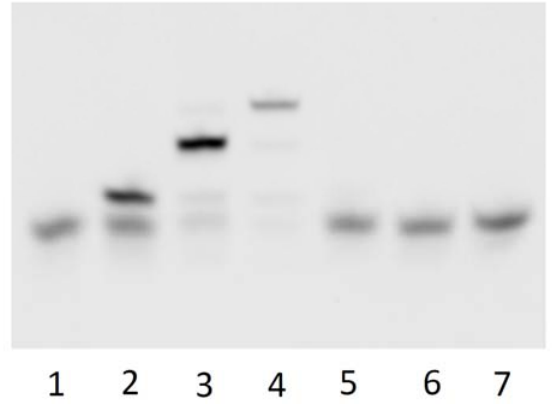
Figure 4. Cy3 fluorescence of a denaturing PAGE of photoreaction of ODN 5, 6, 7 and 8 and template 2 was annealed and photoirradiated at 366 nm for 900 s at 4 °C and 312 nm for 1800 s at room temperature. Lane 1, ODN 5 + template 2 + 366 nm; Lane 2, Lane 1 + ODN 6; Lane 3, Lane 2 + ODN 7; Lane 4, Lane 3 + ODN 8; Lane 5 Lane 4 + 312 nm; Lane 6, Lane 4 without template 2; Lane 7, Lane 4 without 366